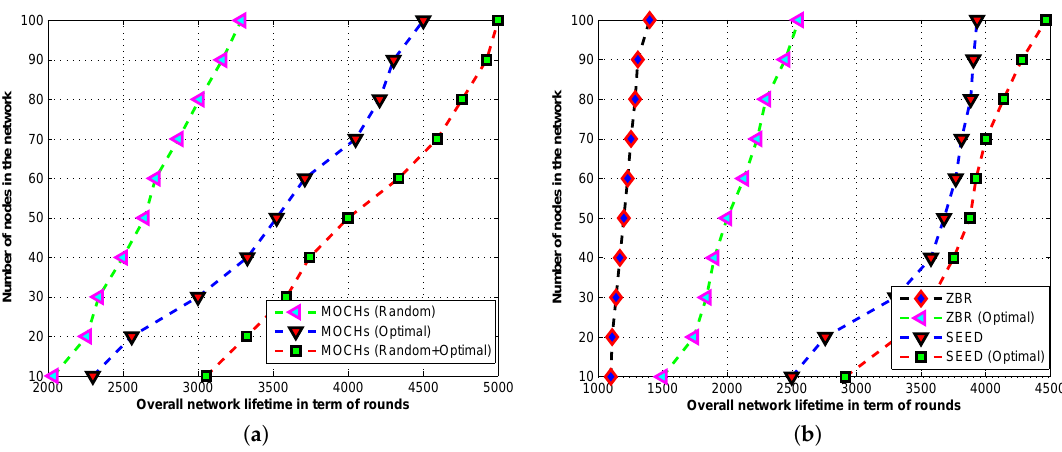
Figure 10. Analysis of random and optimal CHs selection on the lifetime of ZBR, SEED, and the proposed algorithm. ( a ) The effect of random and optimal CHs selection on the lifetime of MOCHs; ( b ) The effect of optimal CHs selection on the lifetime of ZBR, and